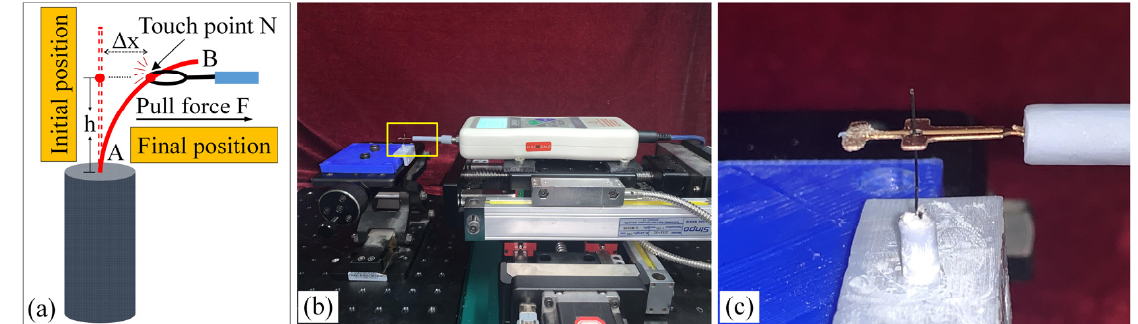
Figure 8. Setup of experimental system for the brush elastic force measurement: ( a ) The principle of the force measurement experiment. ( b ) The force measurement experimental system. ( c ) An enlarged view of the area marked by the yellow box, and it shows the contact part between the clamp and the brush.